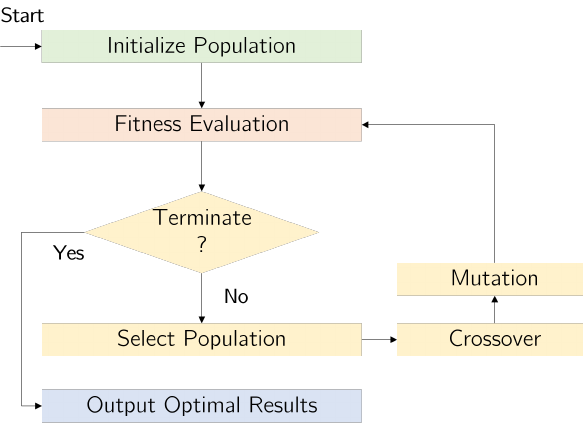
Figure 12. Basic logic of genetic